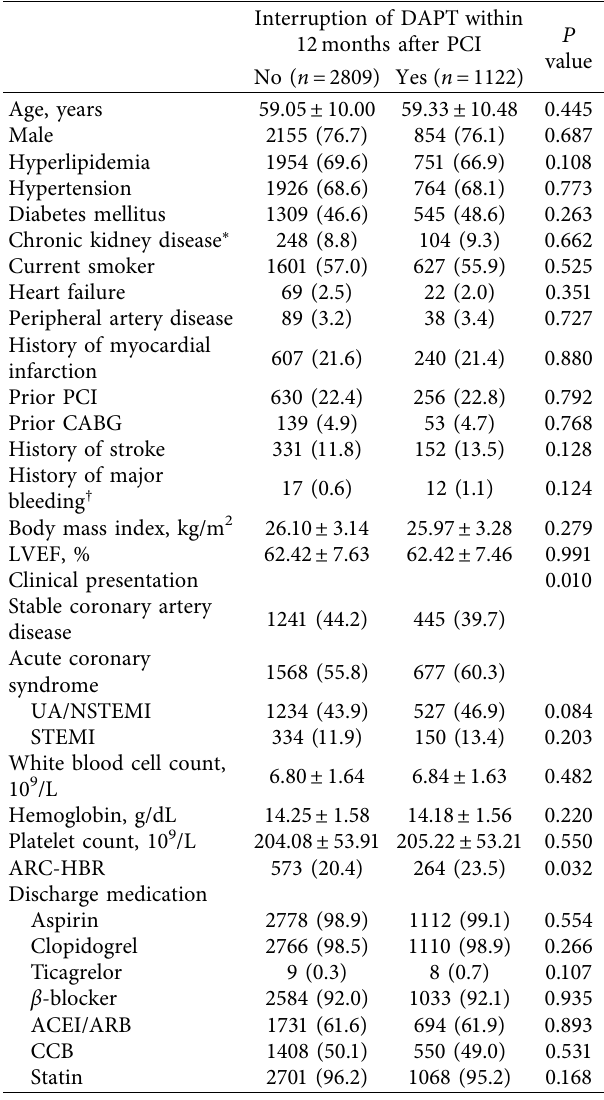
Table 2: Baseline